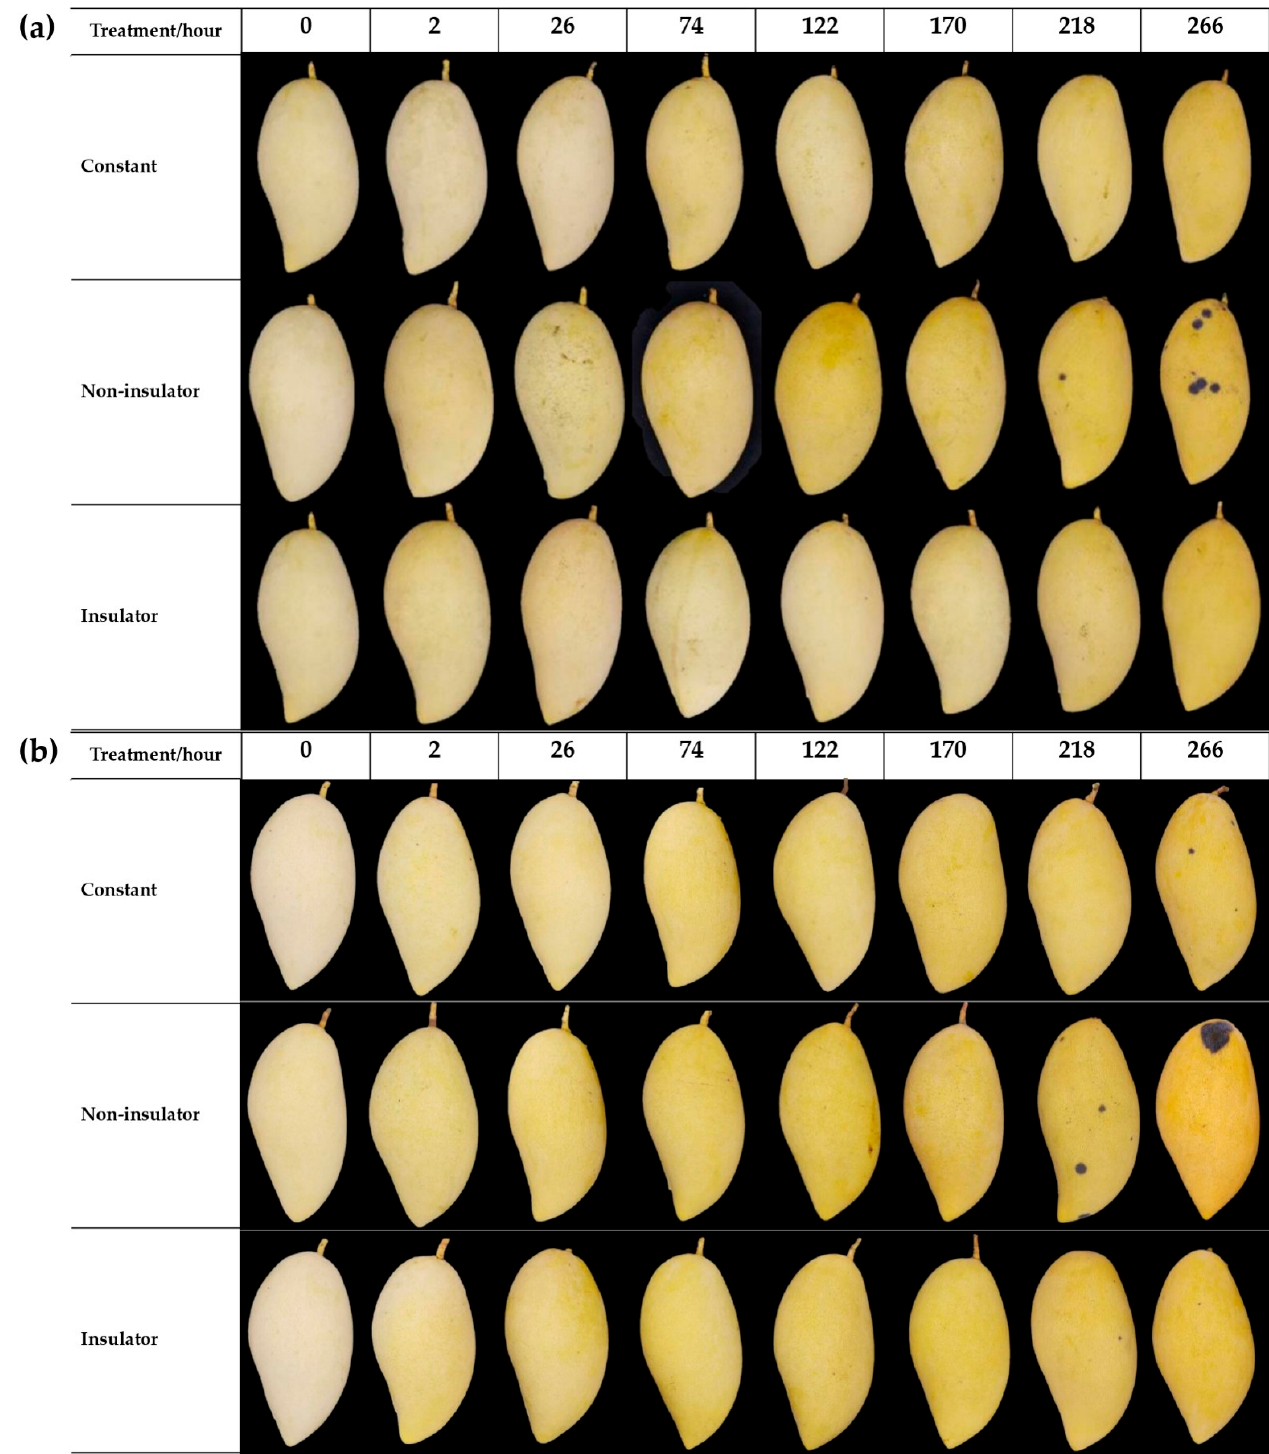
Figure 7. Colour of the peel of mango fruits (‘Nam Dok Mai Si Thong’) from the ( a ) first harvest, and ( b ) second harvest under constant, non insulated, and insulated conditions during simulated handling at the tarmac. After simulated handling at the tarmac, mango fruits were transferred to 20 °C for 266 h.